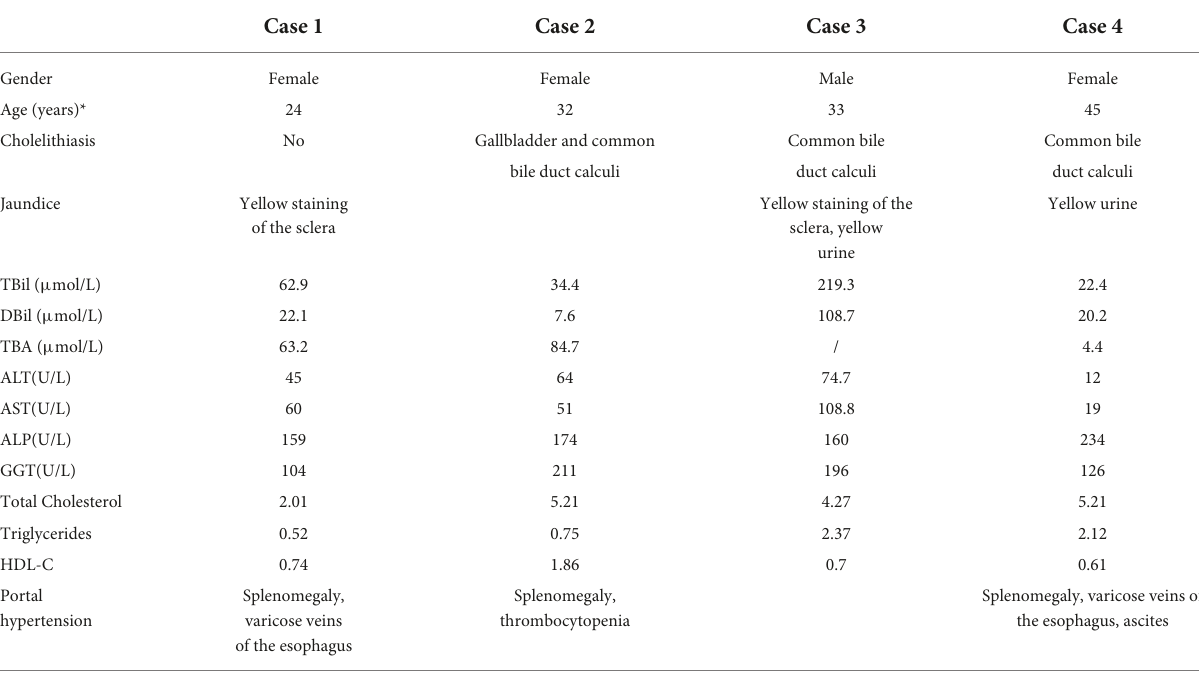
TABLE 1 Clinical characteristics and laboratory findings. Clinical